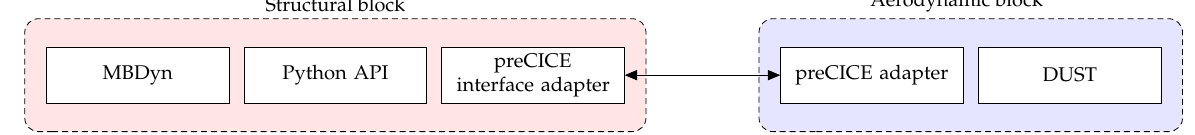
Figure 1. Scheme of the communication managed through adapters for MBDyn and DUST The interface between structural and aerodynamic grids is obtained as a weighted average of the 194 distance between the nodes of the two grids and is used for motion interpolation and consistent force 195 and moment reduction. Figure 2 shows the q nodes of the structural grid, namely Q q . The centers and 196 the vertices of each aerodynamic mesh are respectively P e and P p , where e and p are the corresponding 197 indices. 198